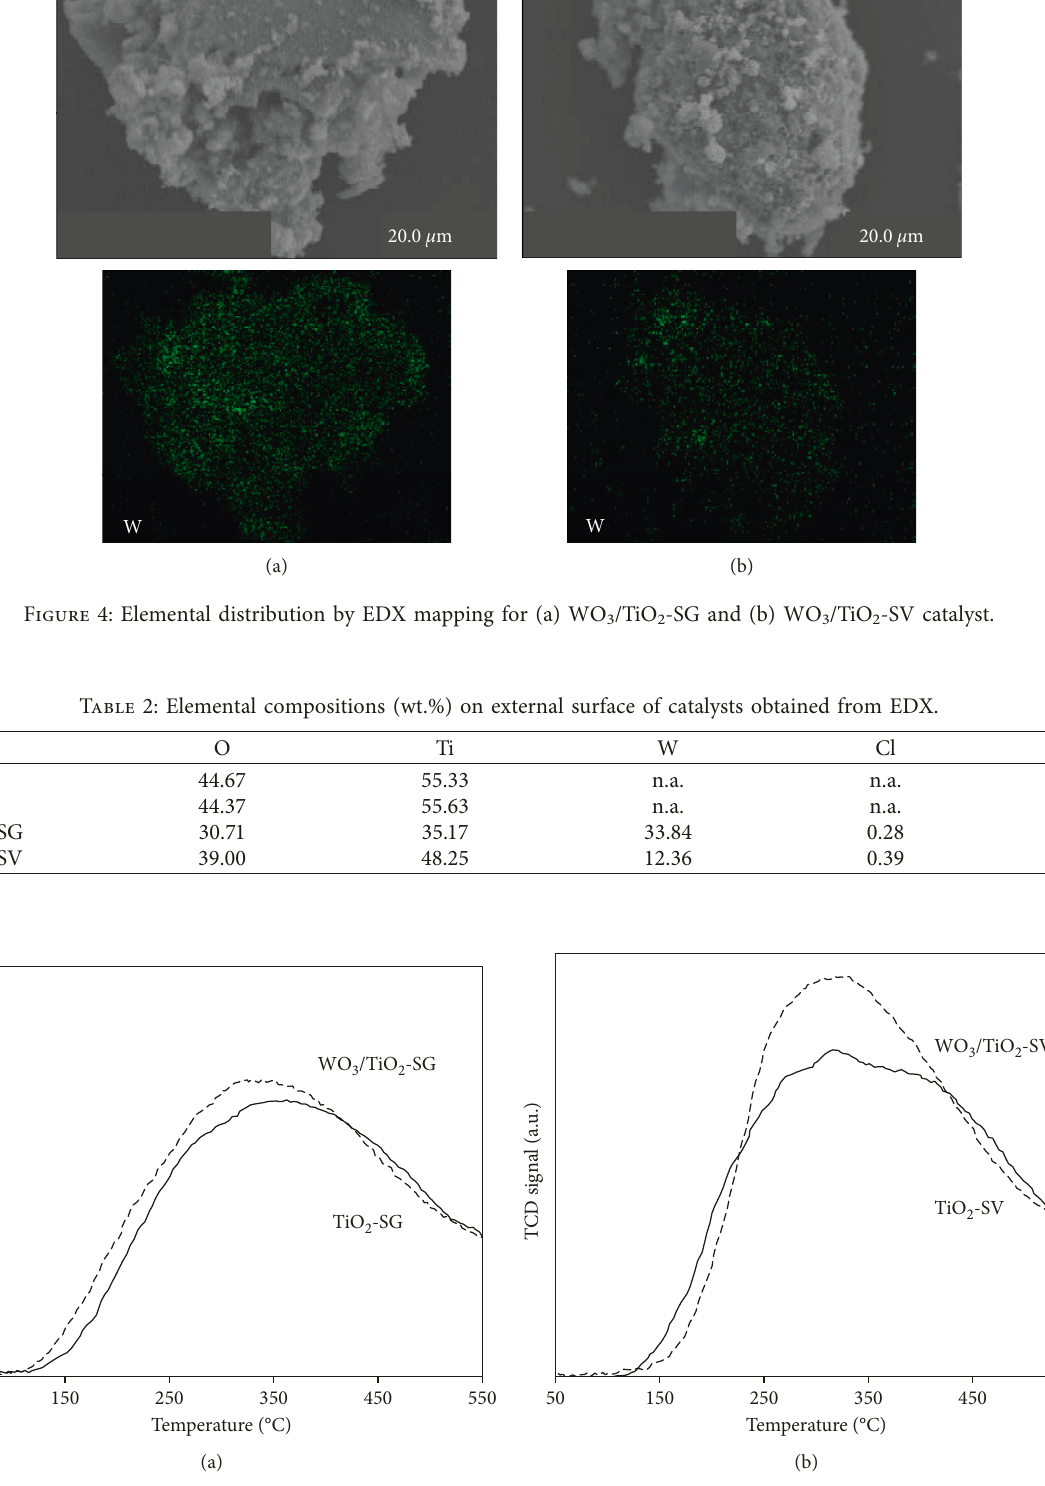
Figure 5: NH 3 -TPD profiles of TiO 2 supports and WO 3 /TiO 2